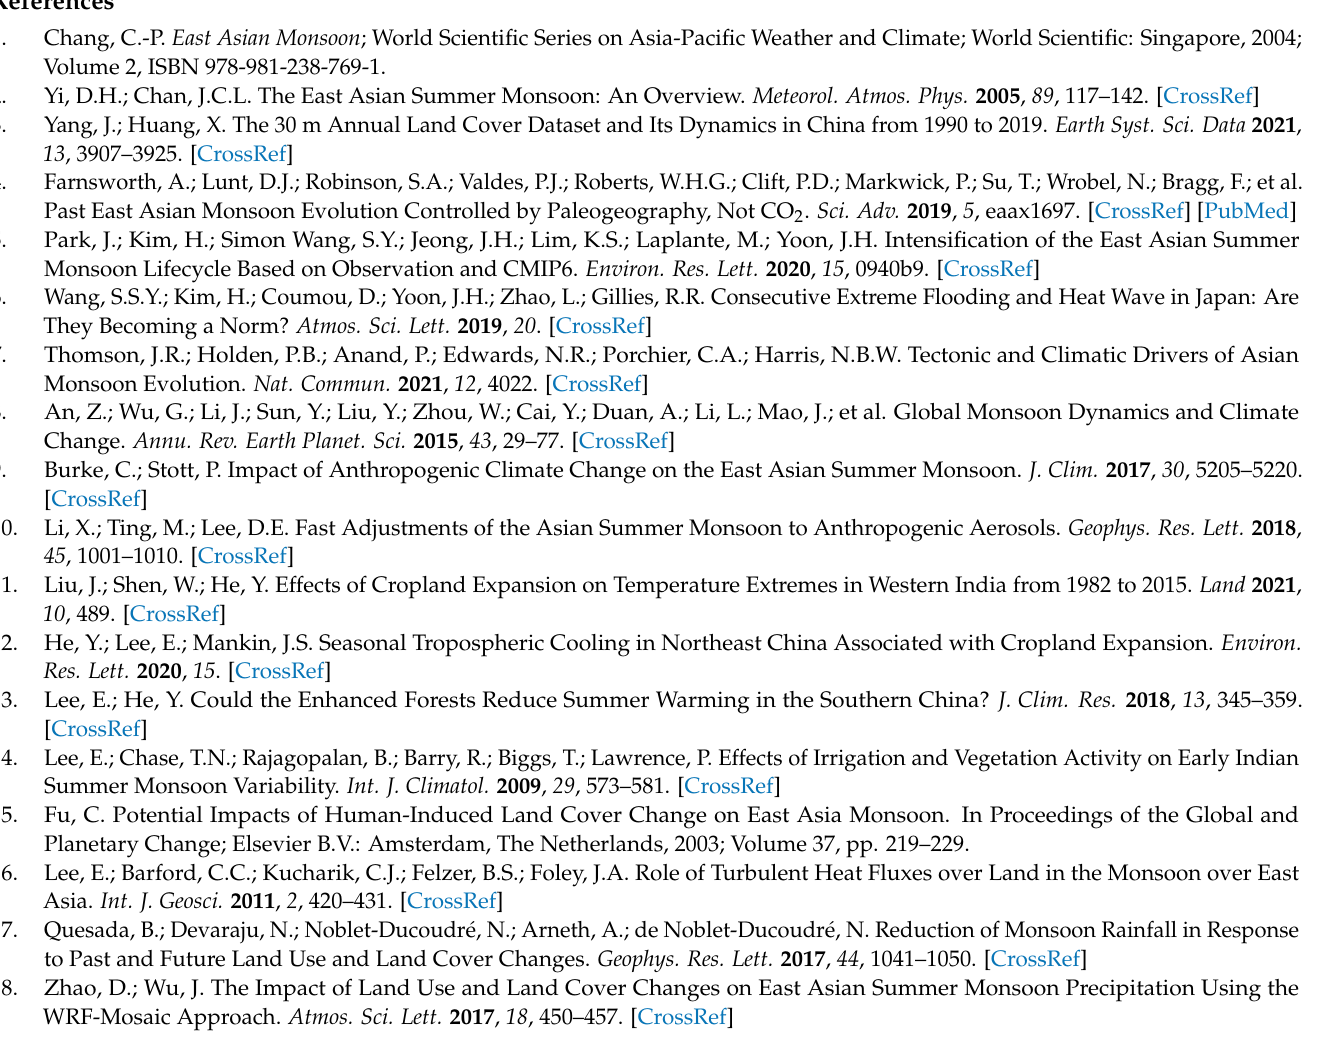
*** represent 10%, 5%, and 1% significant level, respectively).